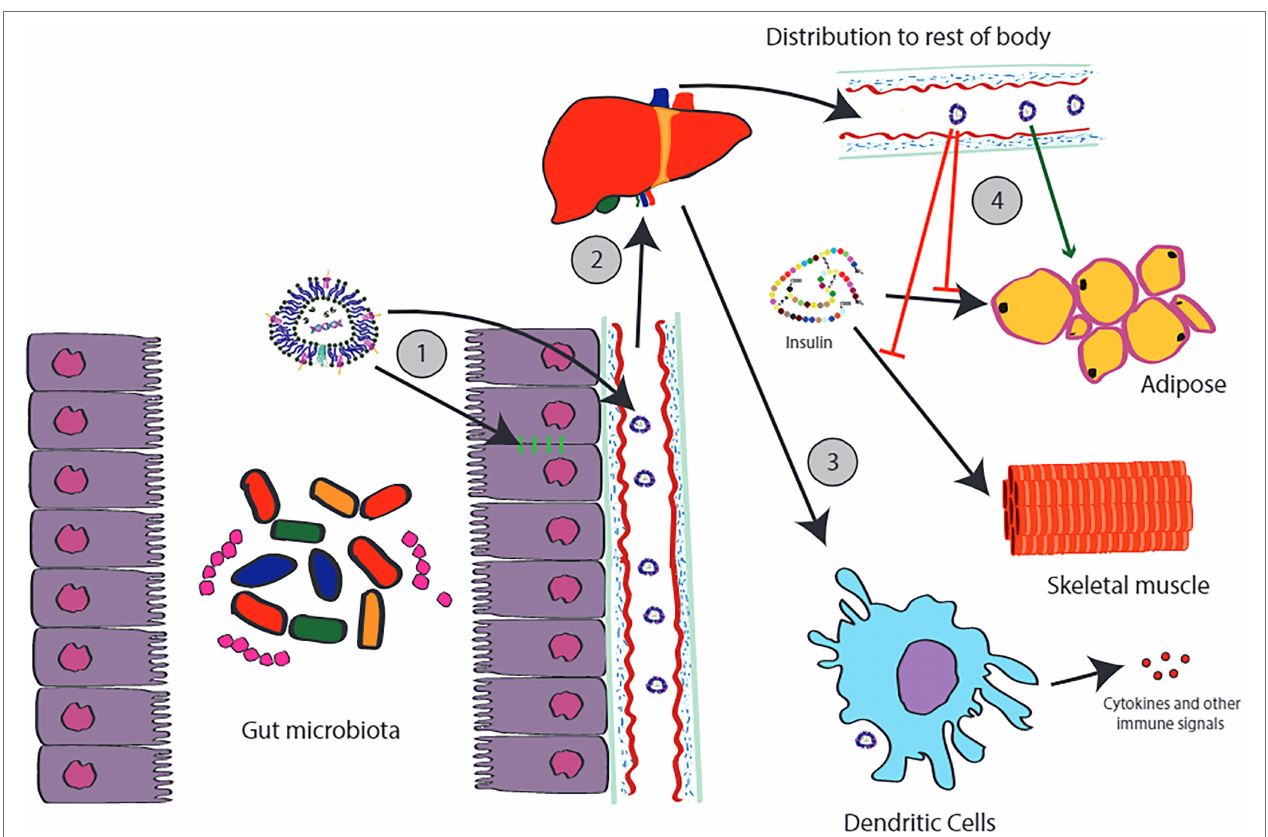
FIGURE 3 | Examples of cross-kingdom signaling involving MVs produced by the gut microbiota. MVs produced by the gut microbiota can act locally, for example, increasing tight junction protein expression in the gut epithelial lining (1). Other MVs can transverse the gut lining where they enter the portal circulation. Most of the MVs that leave the gastrointestinal tract will accumulate in the liver (2). MVs accumulating in these tissues will interact with local dendritic cells, including the Kupffer cells of the liver. Depending on the composition of the MV, this can have a variety of effects. For example, MVs containing indole appear to be anti-inflammatory and appear to protect the liver against steatosis and injury. However, other types of MVs carry MAMPs which can trigger inflammatory responses from the immune system, such as the release of cytokines (3). Some MVs escape hepatic circulation and distribute throughout the rest of the body. Again, depending on the origin and composition of these MVs, differing effects may be observed. MVs from Pseudomonas panacis appear two interfere with the effects of insulin action on adipose tissue (4). In contrast, MVs from Akkermansia muciniphilia appeared to cause positive effects including a loss of body fat. This diagram is only a tiny portion of the full